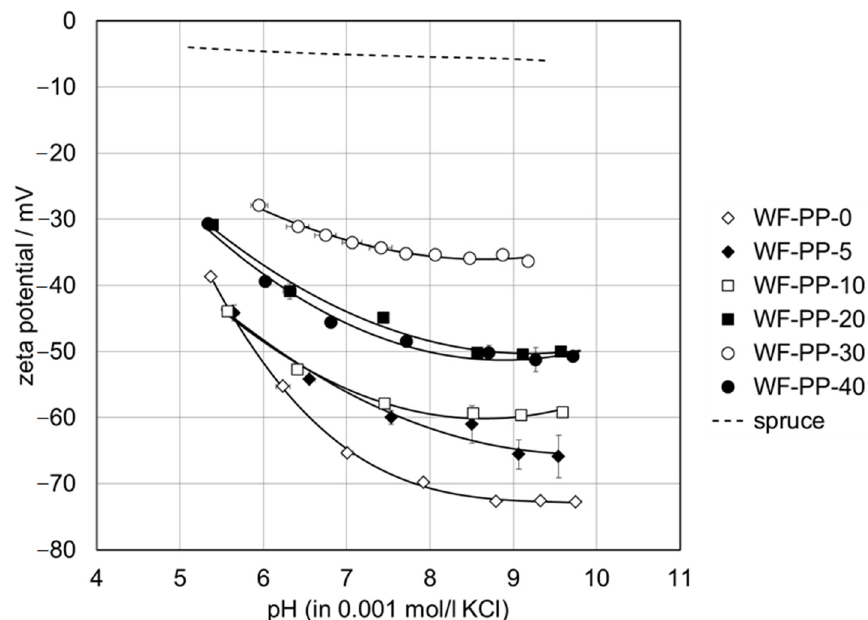
Figure 11. Zeta potential of WF-PP composite samples in the range of pH 5 − 10. The evolution of the zeta potential with pH for spruce as a representative softwood is shown for comparison.